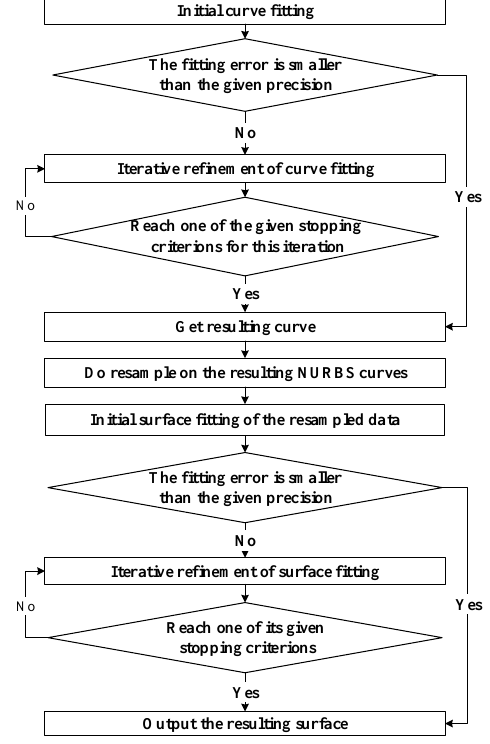
Figure 3. Framework of the method proposed in this paper.